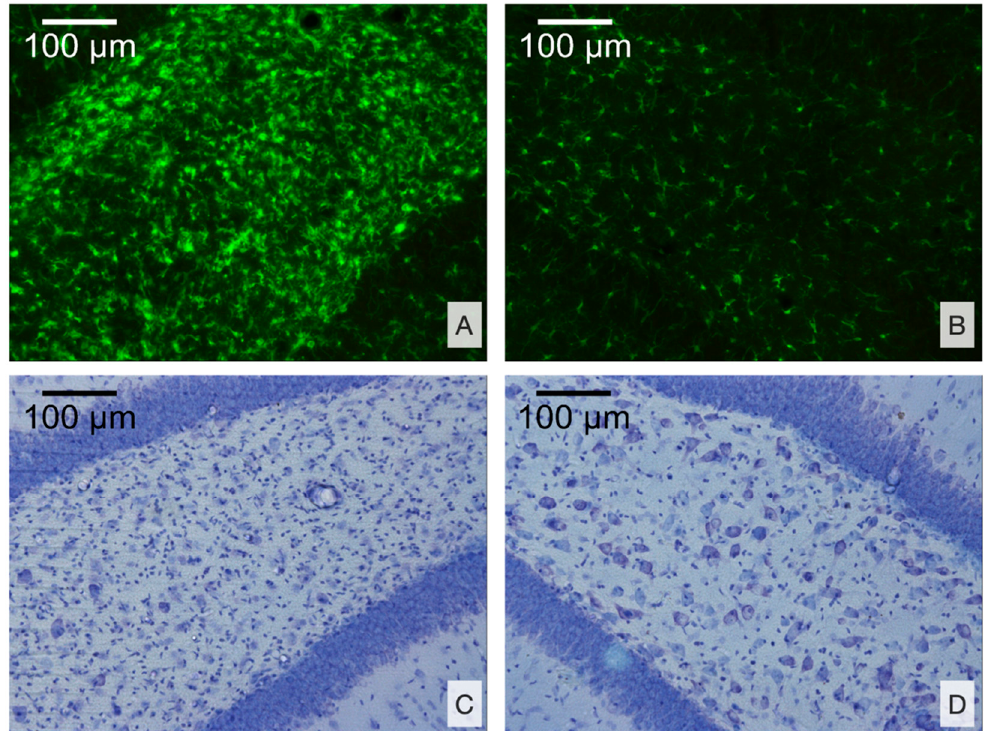
Figure 6. Histological alterations in the hippocampus 7 days after TBI. ( A ) Microglial activation in the dentate gyrus (DG) as compared with the contralateral hemisphere; ( B ) Iba-staining; ( C ) Loss of neurons in the polymorph layer of the DG as compared with the contralateral hemisphere; ( D ) Nissl staining.